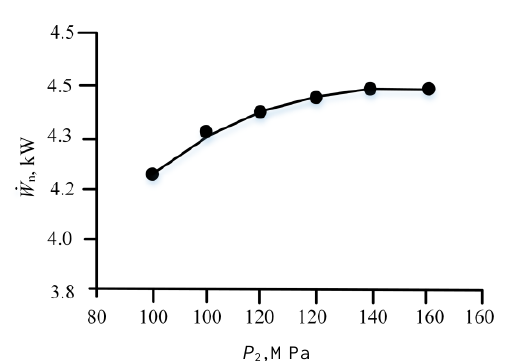
Fig. 6. Variation of net power output with